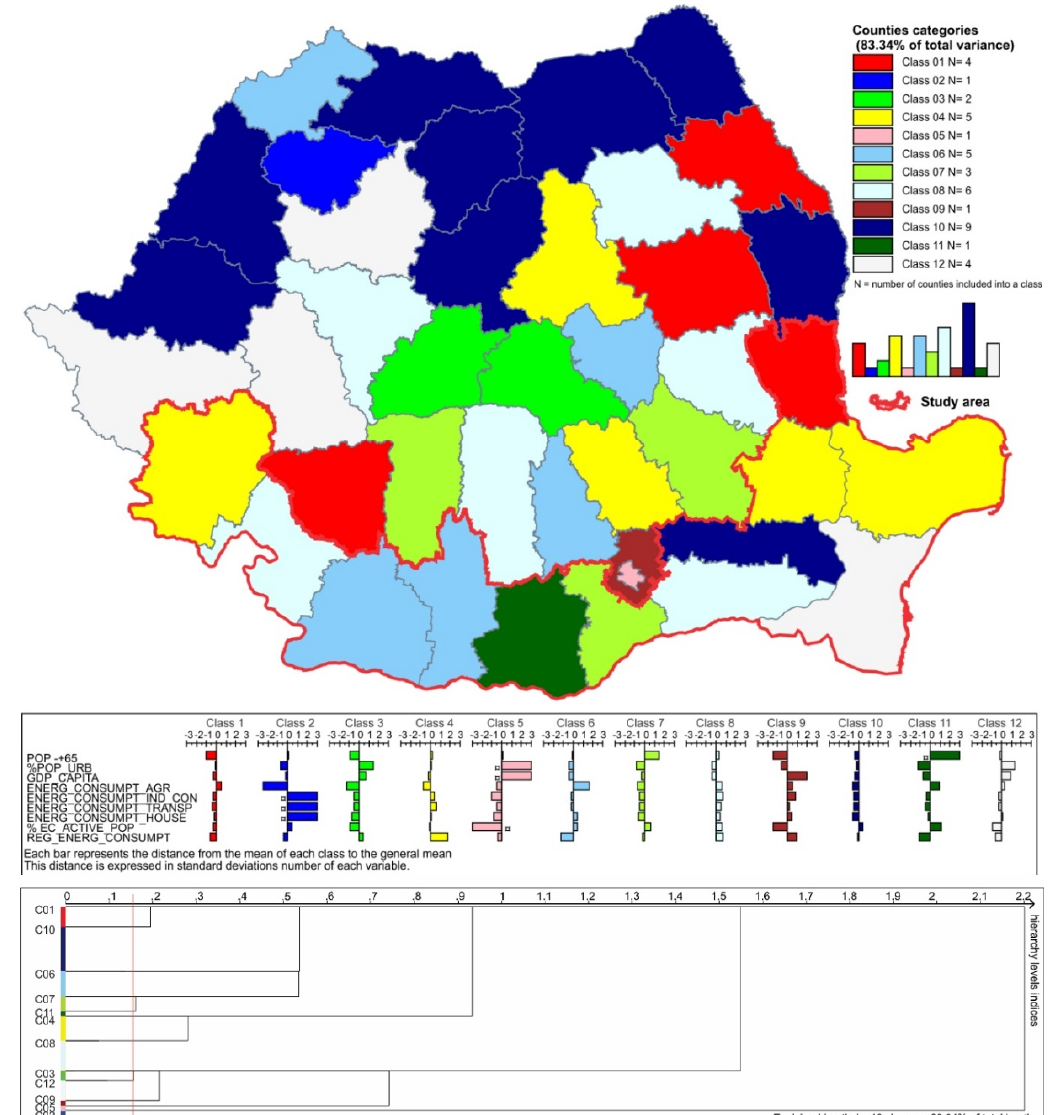
Figure 6. Spatial distribution of the demographic and economic indicators in 2015 (Source: TEMPO Online, National Institute of Statistics), (made with Philcarto, http://philcarto.free.fr).